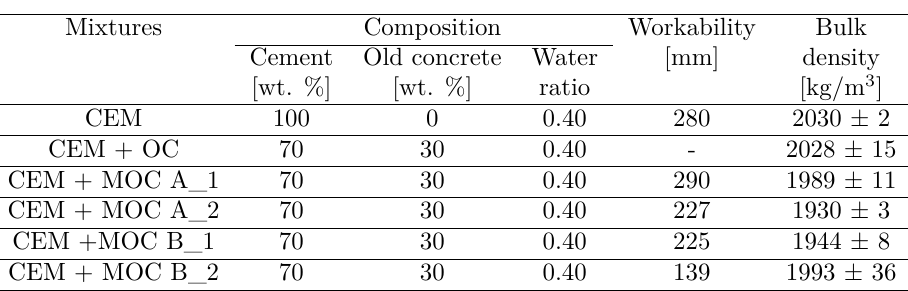
Table 2. Composition of the individual set/mixtures.